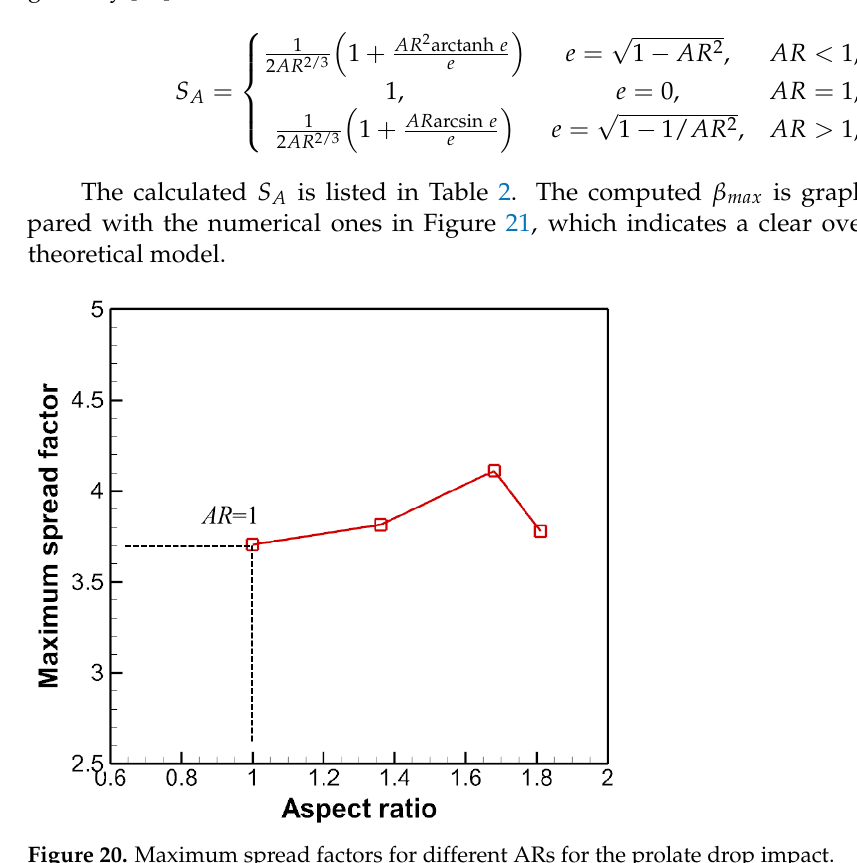
Figure 20. Maximum spread factors for different ARs for the prolate drop impact. Table 2. Calculated S A for various